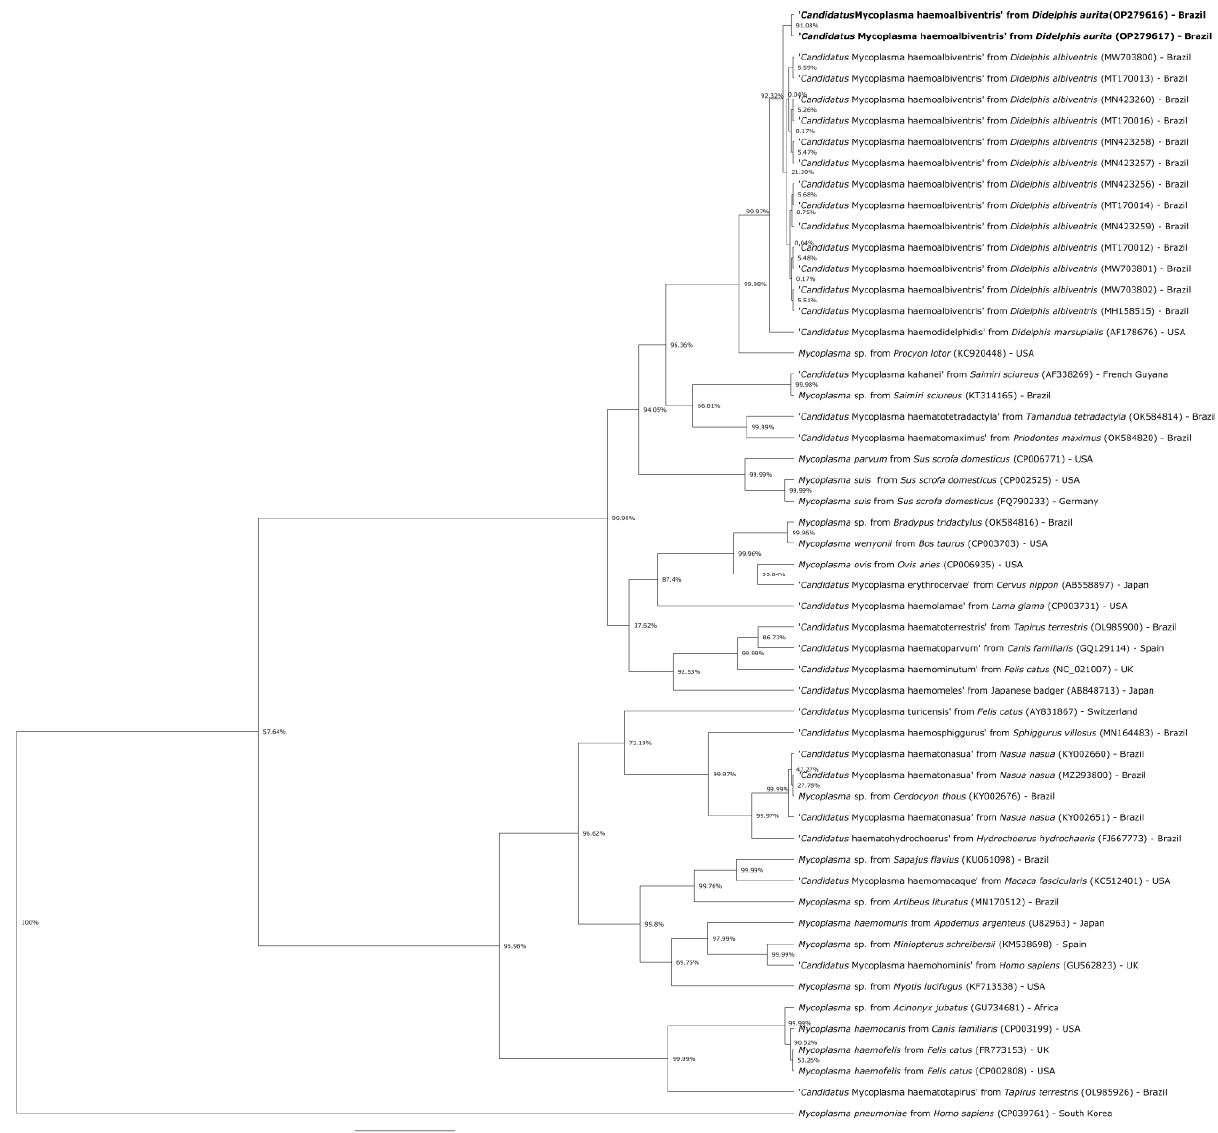
Figure 5. Phylogenetic tree based on partial sequences of the 16S rRNA gene (850 bp), showing the relationship between the hemotropic Mycoplasma sp. detected in the black-eared opossums ( Didelphis aurita ) from this study and other hemoplasmas. Mycoplasma pneumoniae was used as outgroup. The GenBank accession number is in parentheses after the species name and origin of each agent. Bayesian inferences were carried out applying the GTR + I + G model and 1000 bootstrap replicates for all analyses.